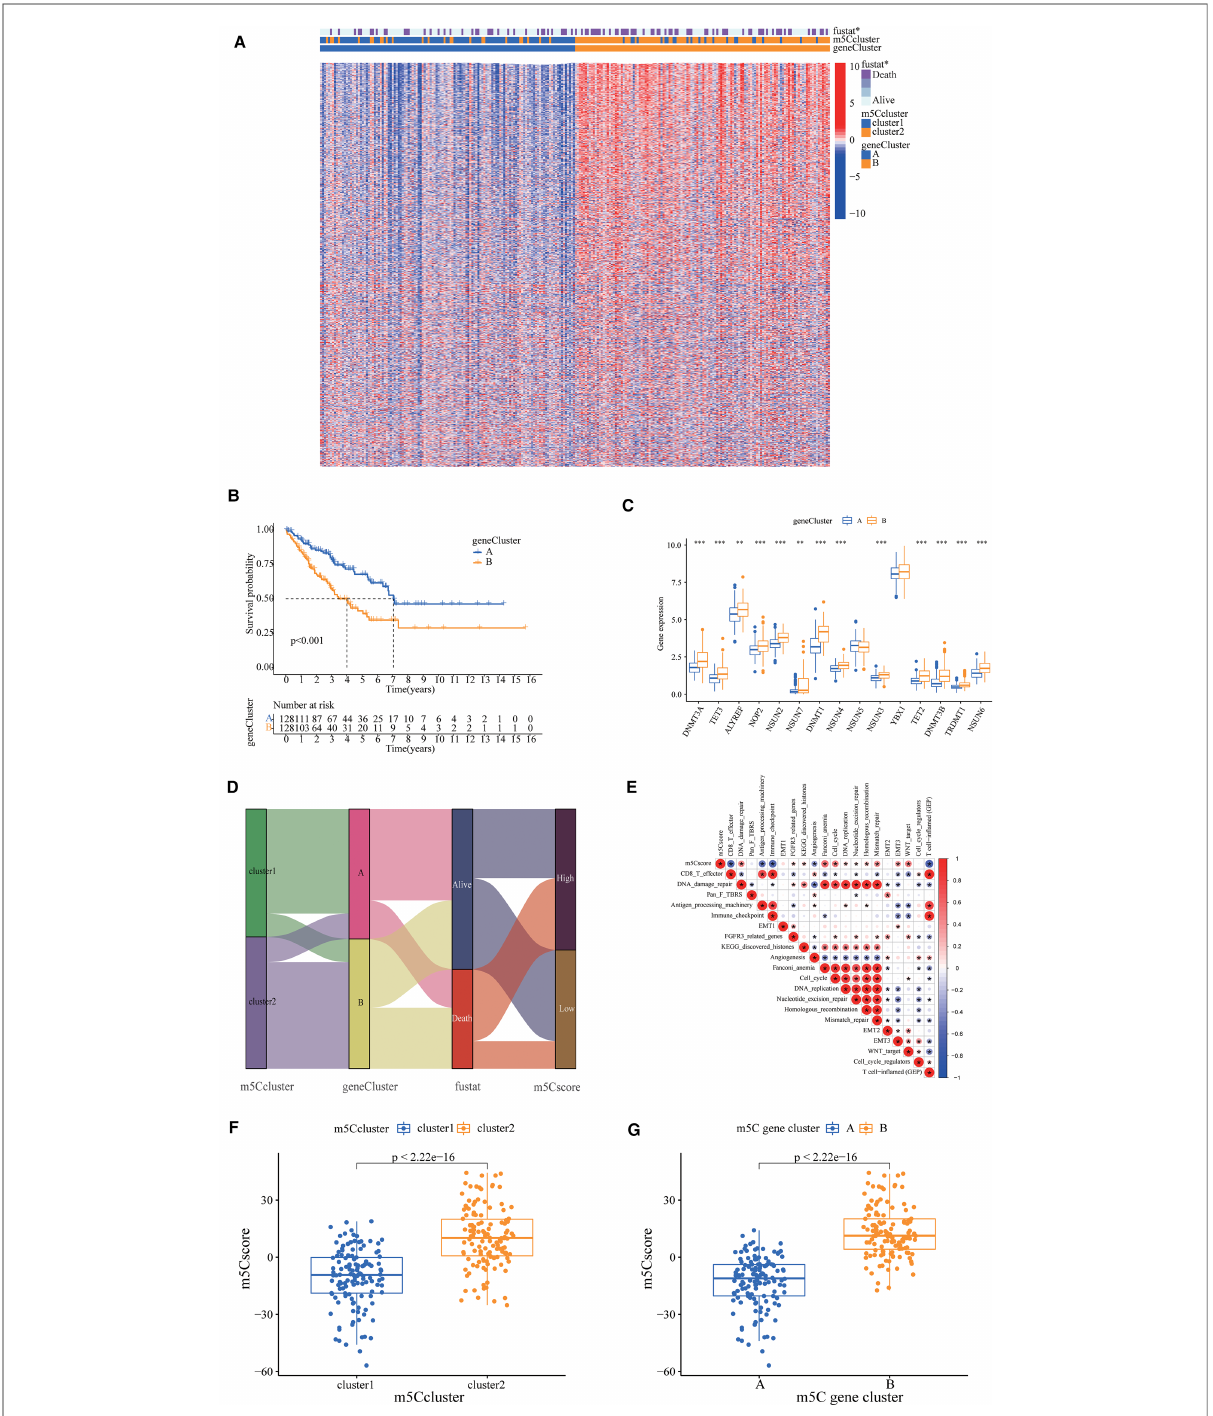
FIGURE 3 5-methylcytosine (m5C) phenotype-related differentially expressed genes (DEGs) in sarcoma. ( A ) A differential expression heat map was drawn to visually illustrate the differences in expression of 990 m5C phenotype-related DEGs between the two groups. ( B ) The survival curve showed different survival rate between two groups. ( C ) The prominent differences in the expression of m5C regulators, the expression of m5C regulators in cluster B was signi fi cantly higher than cluster A. ( D ) A Sankey plot to show the correlation of m5C score, survival status, m5C cluster, and gene cluster. ( E ) Correlations between m5C score and the known gene signatures in The Cancer Genome Atlas cohort using Pearson analysis. Negative correlation was marked with blue and positive correlation with red. ( F ) Wilcoxon test showed a signi fi cant difference in the m5C score between m5C gene clusters, and the score of Cluster A was signi fi cantly lower than that of Cluster B. ( G ) The m5C score of cluster1 in the m5C cluster is also signi fi cantly lower than that of